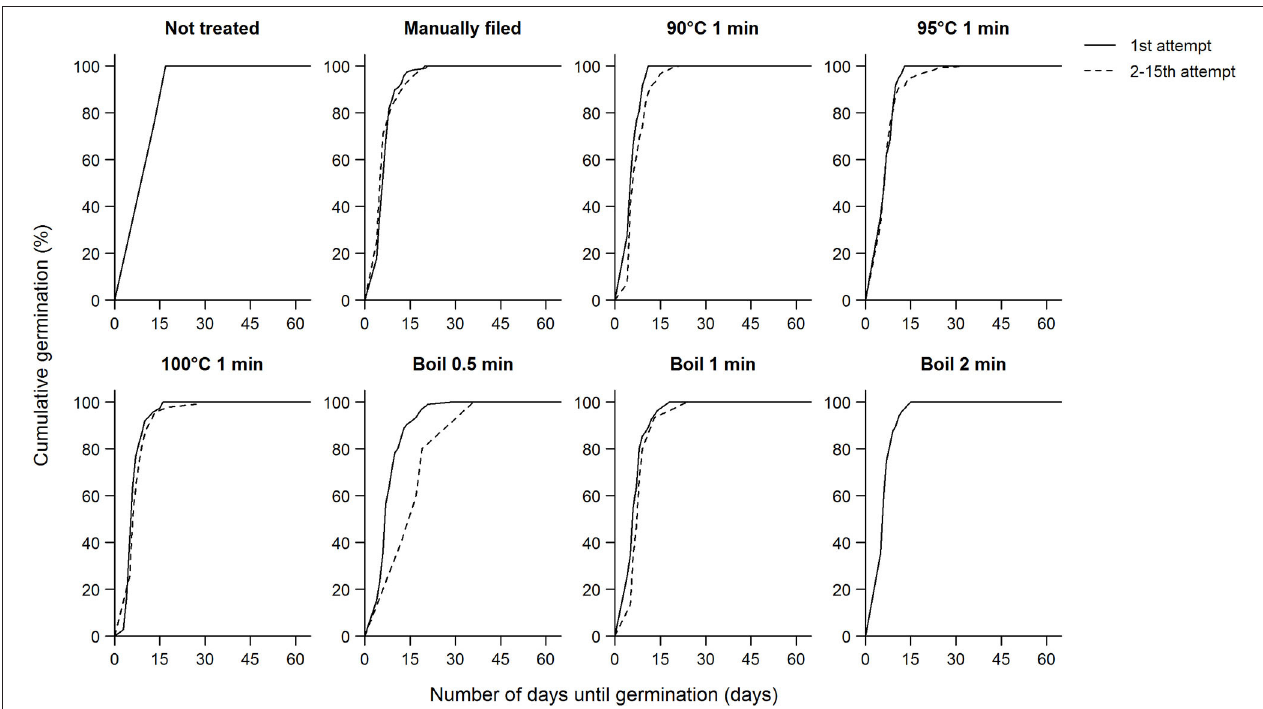
FIGURE 5 | Cumulative germination percentage of viable koa seeds after subjected to each scarification treatment and the number of days until germination shown separately for the first attempt and up to the second through the 15th attempts combined. There was no difference between the first attempt and the second through the 15th attempt combined except for boil 0.5min ( χ 2 = 6.2, df = 1, P = 0.01). Data for each subpanel are for seeds from nine trees subjected to all scarification